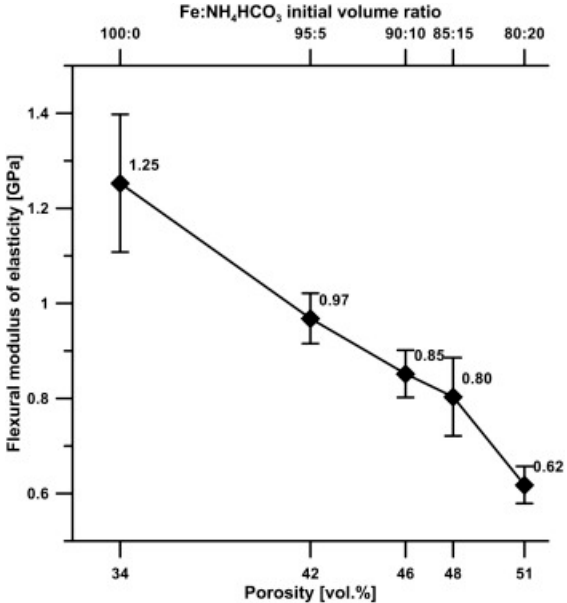
Figure 3. Flexural modulus of elasticity versus porosity. Reprinted from Reference [45] with permission from Elsevier.